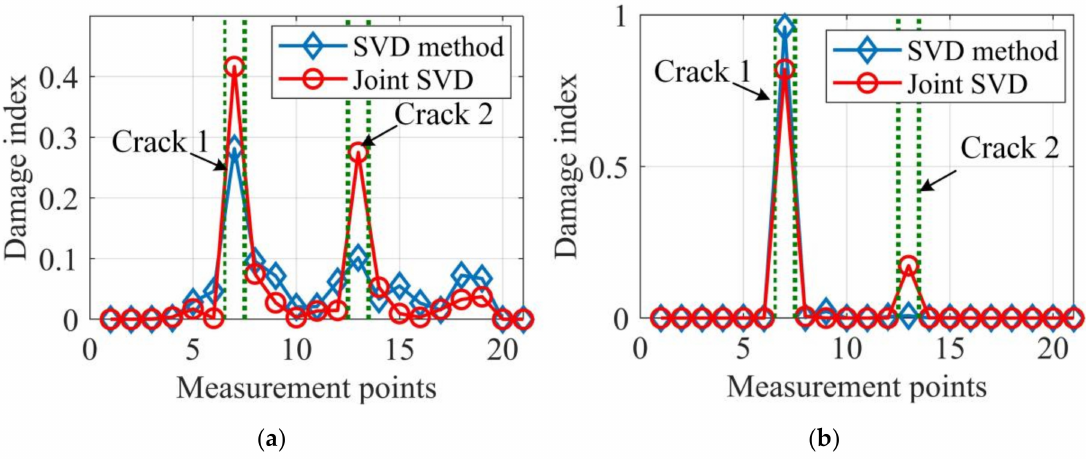
Figure 12. Integrated damage indexes of experimental case 2. ( a ) Proposed data fusion approach; ( b ) Bayesian